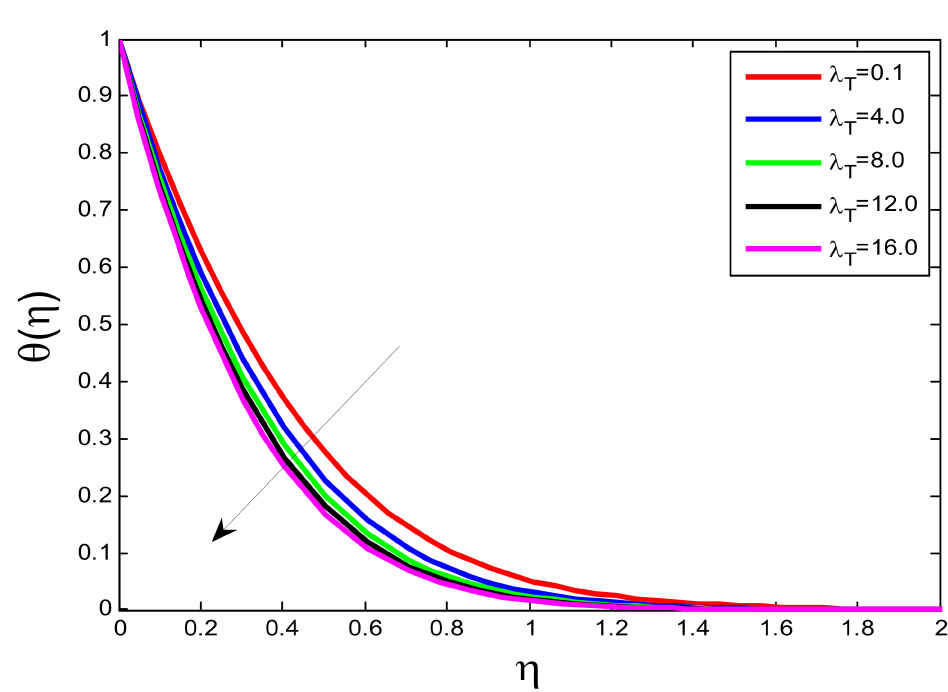
Figure 3. Influence of λ T on θ ( η )